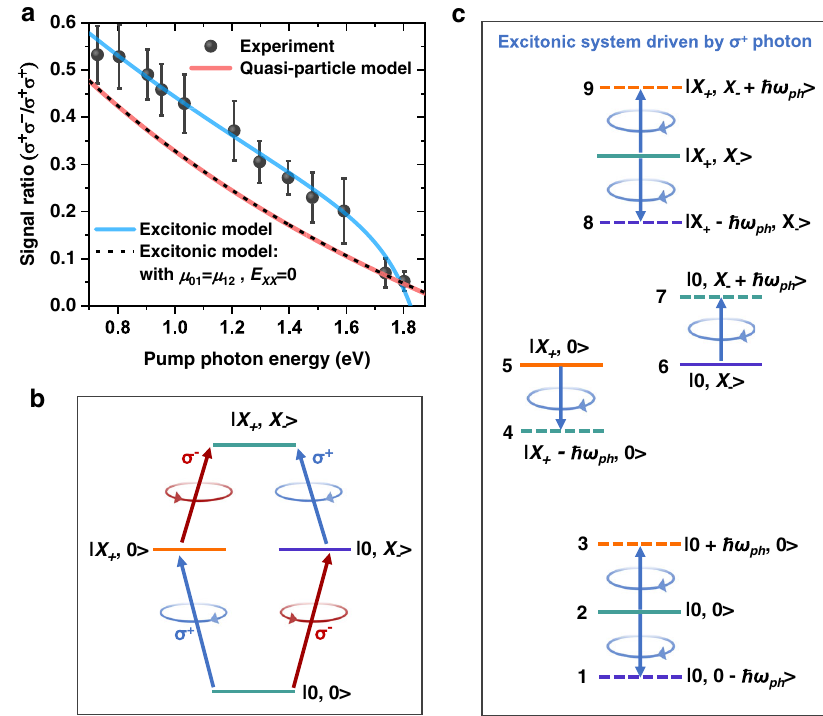
Fig. 4 | Excitonic Bloch – Siegert shift in CsPbI 3 QDs. a Ratio between the normal Bloch – Siegert and optical Stark shifts measured with σ + σ − and σ + σ + con fi gurations, respectively (gray balls). The red solid line is the prediction by a non-interacting, quasi-particle model (Eq. (3)), whereas the blue solid line is obtained using our excitonic model (Eq. (4)) with μ 01 =34 D, μ 12 =28 D and E XX =65meV. By setting μ μ 01 = 12 and E XX =0, our excitonic model (black dashed line) reduces to the quasi- particlemodel.Theerrorbarsareobtainedfromthestandardvariationsof σ + σ + and σ + σ − signals in the range of ±40fs around time-zero. b States and optical